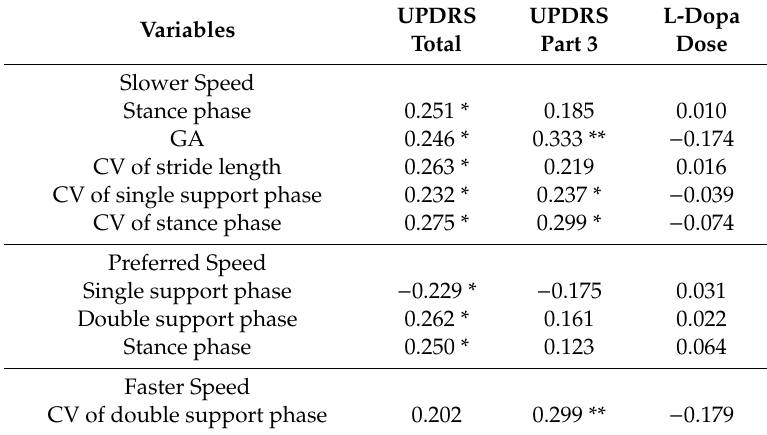
Table 4. Pearson’s product moment correlation analysis between clinical data and gait variables of PD patients at slower, preferred, and faster